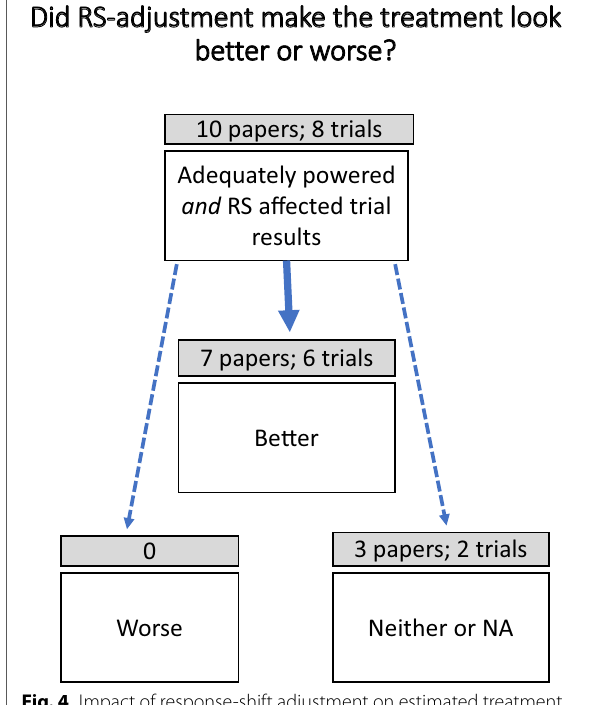
DDiidd RRSS--aaddjjuussttmmeenntt mmaakkee tthhee ttrreeaattmmeenntt llooookk